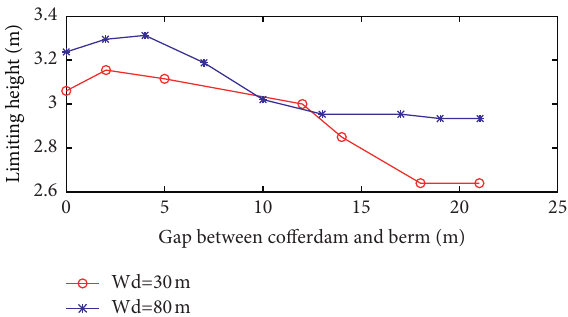
Figure 10: Effect of gap between cofferdam and berms on limiting stack height and safety factor of